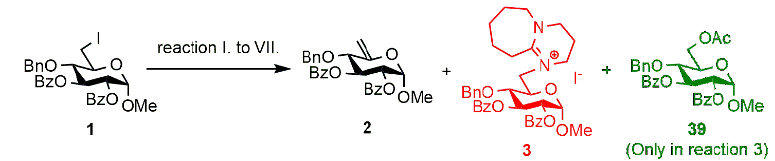
Scheme 2. Optimization of the synthesis of the cationic molecules. Table 1. Optimization trials to improve the yield of the DBU-conjugated